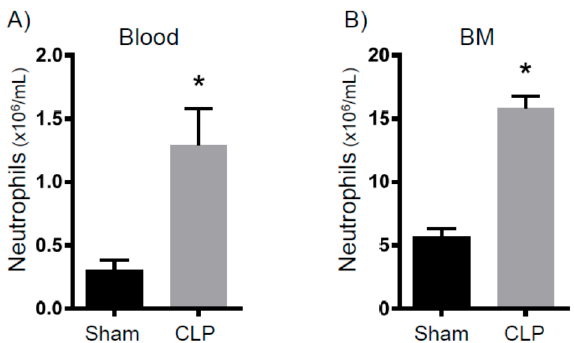
Figure 1. Leukocytosis and bone marrow myelopoiesis eight days after cecal ligation and puncture (CLP). Mice were subjected to either sham surgery ( N = 13) or CLP ( N = 17). Eight days later, animals were sacrificed and flow cytometry was used to characterize the number of ( A ) neutrophils in the blood and ( B ) neutrophils in the bone marrow. * p < 0.05 versus sham.